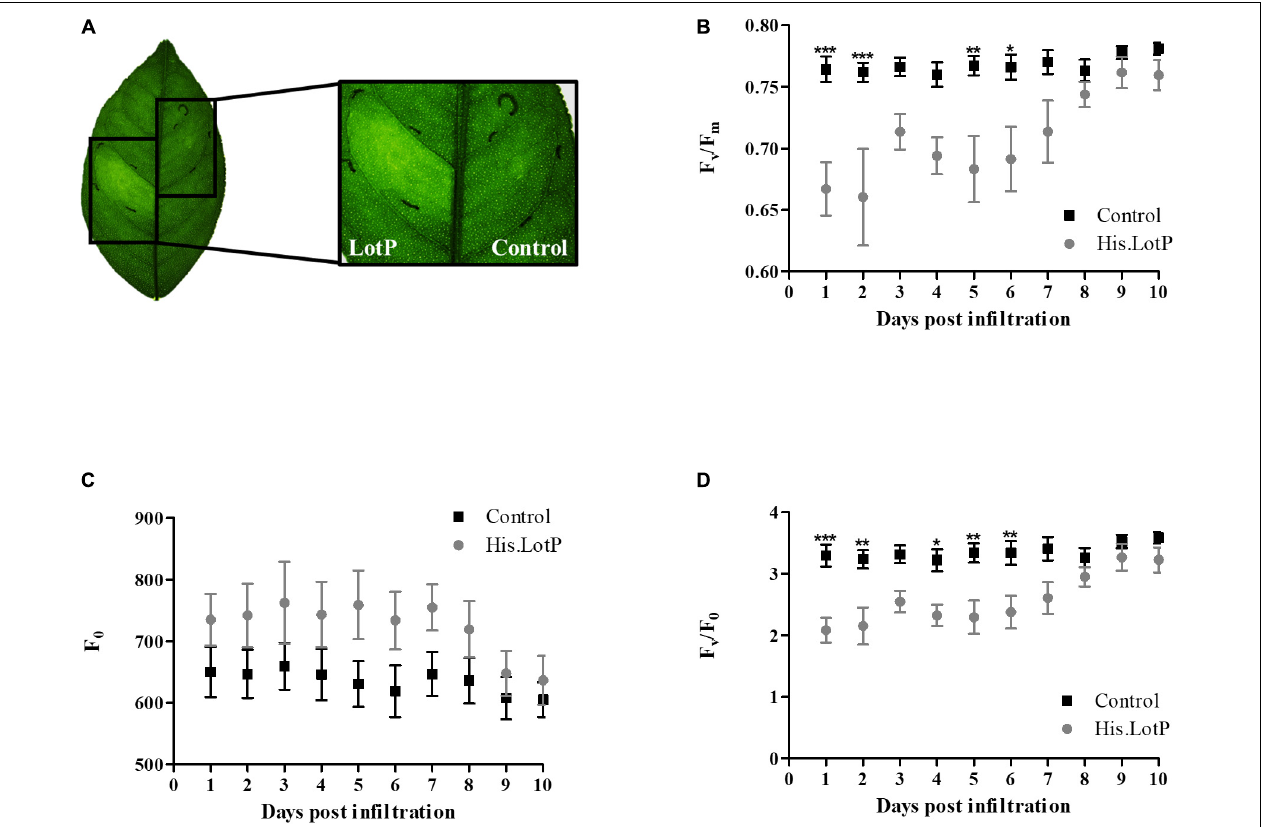
FIGURE 9 | His.LotP causes chlorosis and affects stress levels within citrus. (A) Chlorotic effect of His.LotP on citrus leaf in comparison with the vehicle buffer control. Citrus sinensis cv. Valencia plants were exposed to purified His.LotP (8 µ M) protein, and photosystem II activity was estimated using the chlorophyll fluorescence parameters F v /F m (B) , F 0 (C) , and F v /F 0 (D) . Measurements taken with vehicle control samples are in black squares, while His.LotP measurements are in gray circles. Data are averages ± SEM ( n = 7). Differences were identified using two-way ANOVA and Tukey’s post-hoc test. Significance is shown as stars: * p < 0.05, ** p < 0.01, *** p <